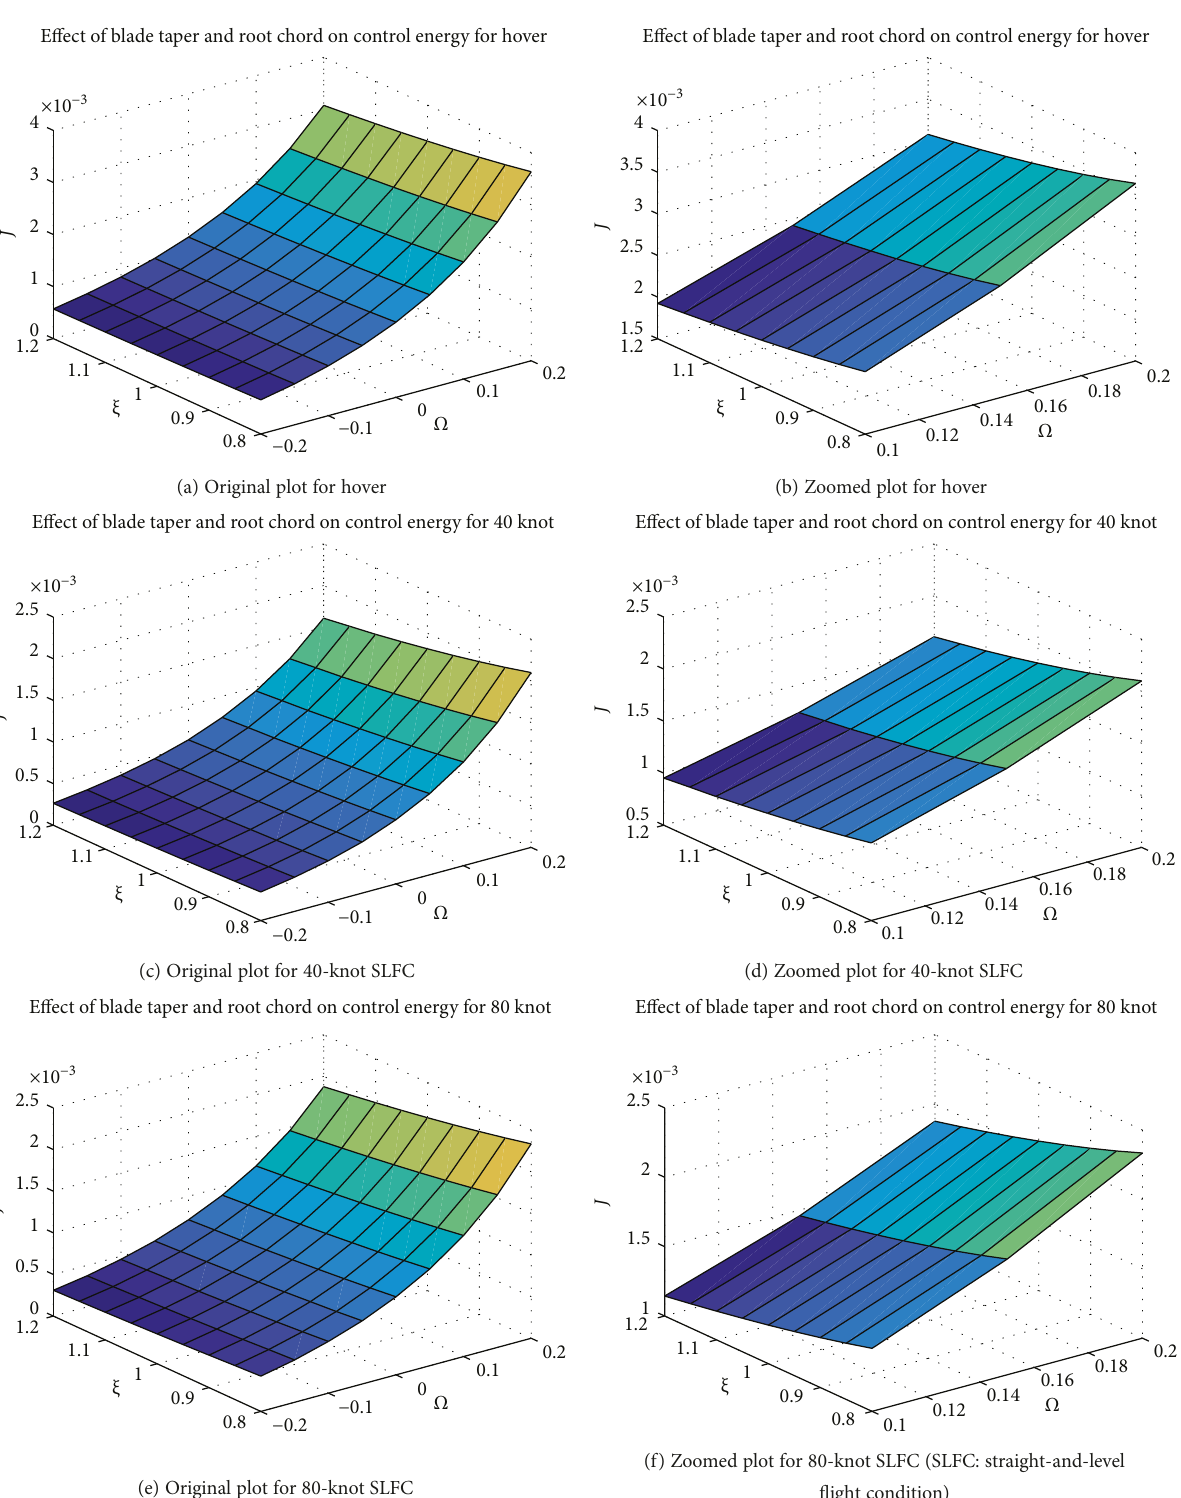
Figure 6: E ff ect of simultaneous variation in blade root chord and blade taper on the control e ff ort (i.e., control energy) of the FCS of a